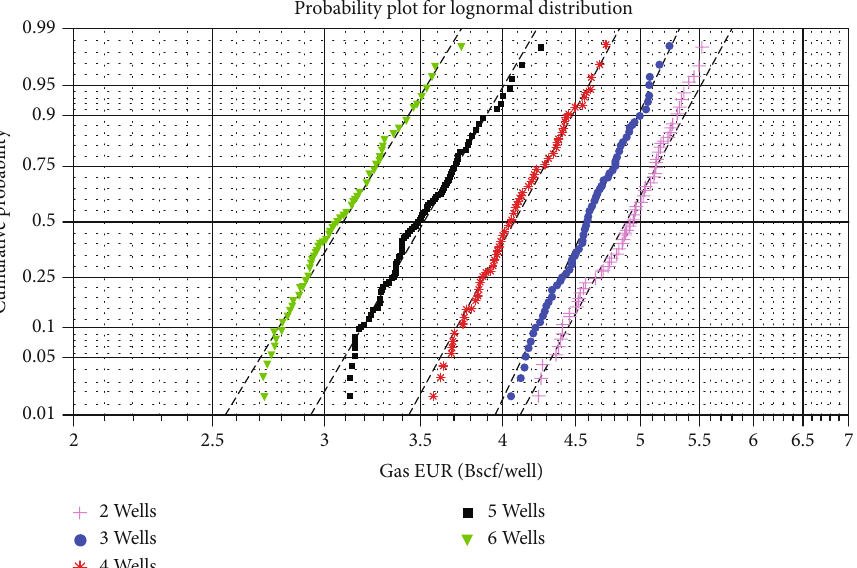
Figure 11: Gas estimated ultimate recovery per well for di ff erent scenarios: (a) two-well with spacing of 1550ft, (b) three-well with spacing of 1033ft, (c) four-well with spacing of 775ft, (d) fi ve-well with spacing of 620 ft, and (e) six-well with spacing of 517